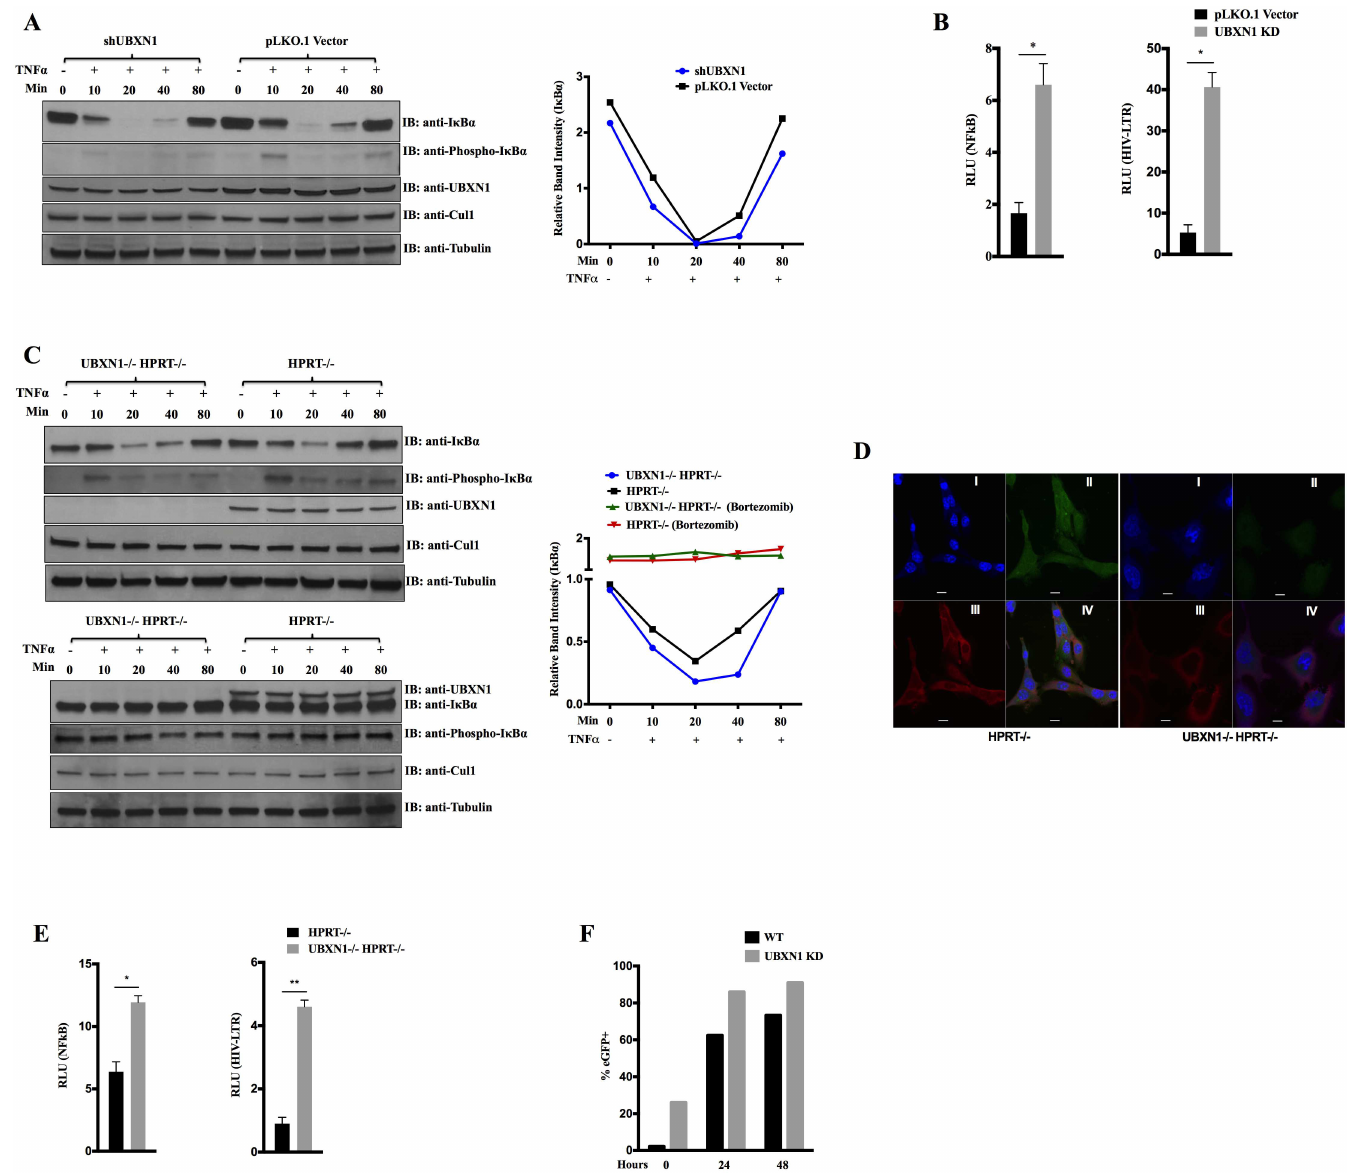
Fig 6. UBXN1 blocks NF κ B signaling and inhibits HIV LTR activity. (A) Left: immunoblot of indicatedproteins from HFFs stably transduced with either empty HIV-basedvector or vector encodinganti-UBXN1 shRNA, after stimulationwith 5 ng/mL TNF α for indicatedtimes; right: relativeband intensity of I κ B α ,normalized to β− tubulin(in the left immunoblot image); (B) Quantificationof NF κ B (left) and HIV LTR (right) FFLUC reportersin cell lines of (A) , normalized to co-transfected Renilla-LUC plasmid; for NF κ B reporter cells were treated for 4 h with 5 ng/mL TNF α 48 h post-transfection; (C) Left: immunoblot of indicatedproteinsfrom UBXN1-/- HPRT-/- and control HPRT-/- MEFs, after stimulationwith 10 ng/mL TNF α for indicatedtimes (upper)or treated with 1 μ M Bortezomib for 5 h and then stimulatedwith 10 ng/mL TNF α for the indicatedtimes (lower); right: relative band intensity of I κ B α , normalized to β− tubulin(in the left immunoblot images); (D) Confocal immunofluorescencemicroscopyof UBXN1 and Cul1 in UBXN1-/- HPRT-/- and control HPRT-/- MEFs. NuclearDNA stained with TO-PRO-3 (I); UBXN1 (II) and Cul1 (III) were stainedusing secondary antibodies conjugated to Alexa Fluor 546 and 488, respectively;IV shows merge; Scale bar = 10 μ m; (E) Quantification of NF κ B and HIV LTR-FFLUC reportersin UBXN1-/- HPRT-/- and control HPRT-/- MEFs. Left: NF κ B-FFLUC values 48 h post-transfection in the presence of 5 ng/mL TNF α for 4h, normalizedto Renilla-LUC reporter; right: HIV LTR-FFLUC values 48 hrs post-transfection, similarlynormalized; (F) JLAT10.6 T cells stably transduced with either HIV-basedvector encoding anti- UBXN1 shRNA or control empty vector, after stimulatingthe cells with 5 ng/mL TNF α for the indicatedtimes and measuring % eGFP+ by FACS. Data in (B) and (E) represent mean ± SEM (n = 3). ** p < 0.005, * p < 0.05 by student’s t-test. Experiments of (A) and (C) were repeatedseveral times, with similar